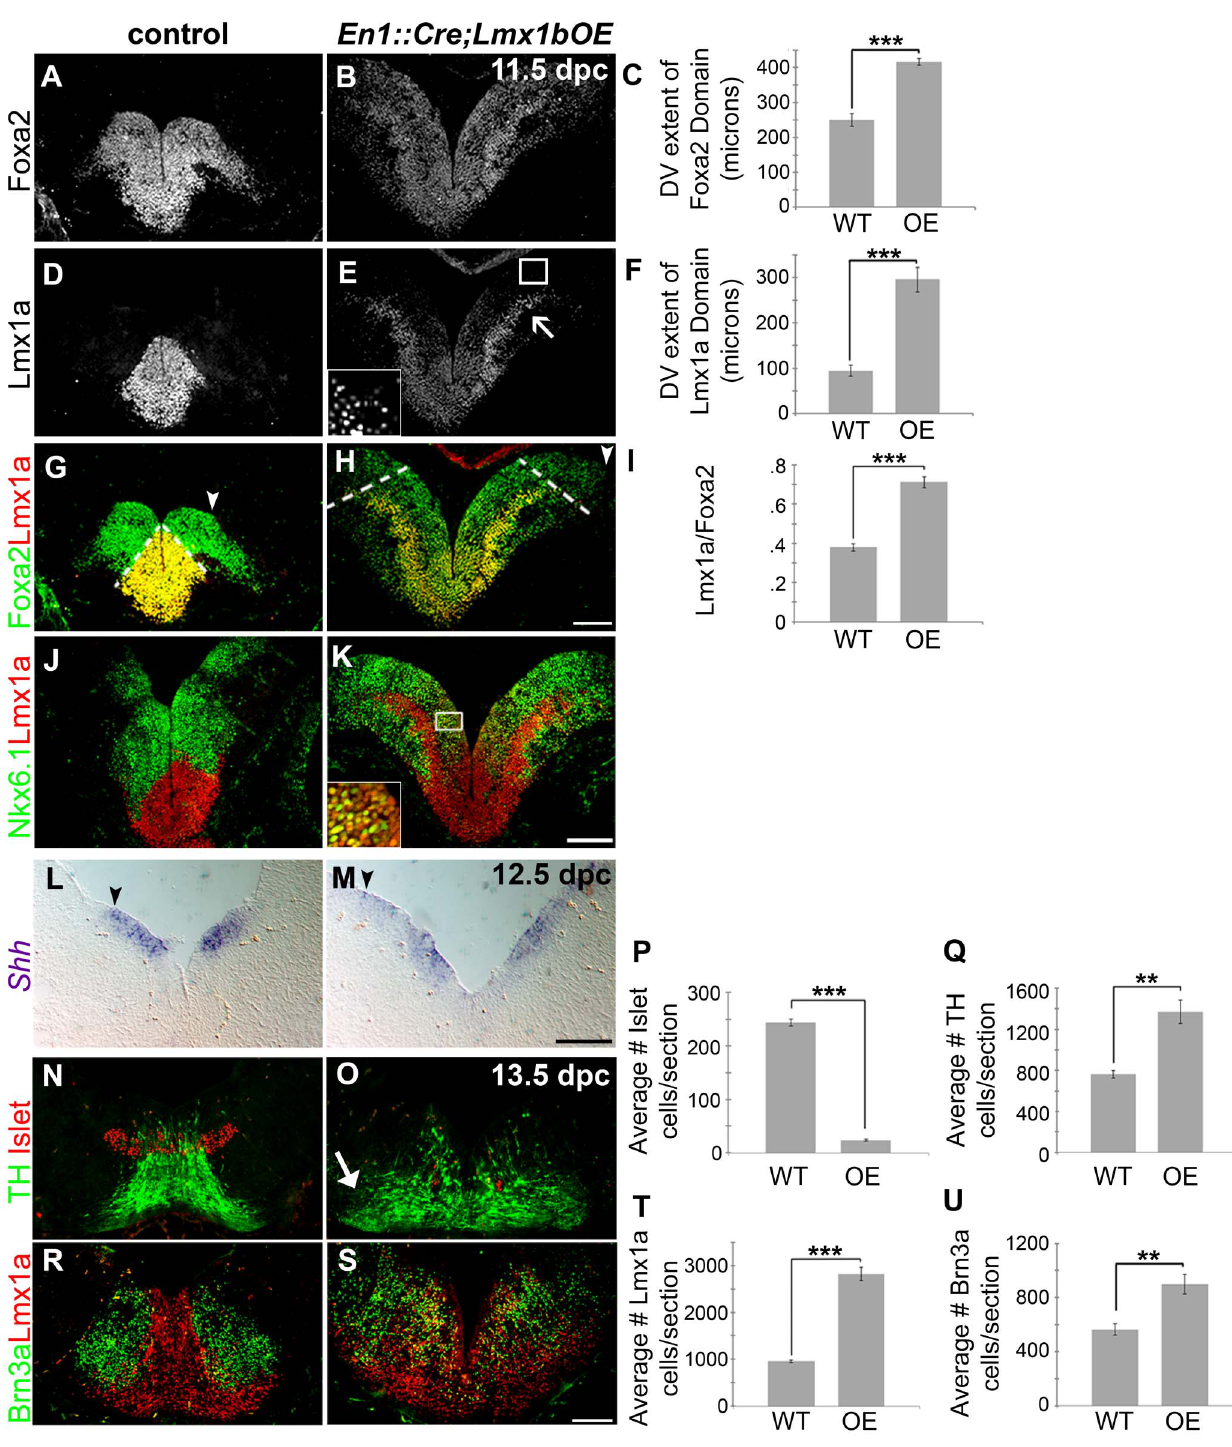
Figure 5. Maintenance of Lmx1b alters the size of the FP, the mDA progenitor pool, and ventral midbrain patterning. (A–K) Immunolabeling of 11.5 dpc En1::Cre;Lmx1bOE embryos revealed the dorsal expansion of Foxa2 and Lmx1a progenitor domains, although per cell levels of both markers were reduced. The closed white arrowheads indicate the dorsal border of Foxa2 expression, graphically represented in C (n=3; control mean=251.27 6 18.20 m M, mutant mean=416.19 6 9.20 m M; p-value=0.855E-05). The dotted white lines indicate the dorsal border of Lmx1a expression, graphically represented in F (n=3; control mean=94.67 6 11.73 m M, mutant mean=295.30 6 26.58 m M; p-value=0.0002), and as a normalized ratio in I (p-value=0.0006) (white box in E surrounds the border region of Lmx1a progenitors, which is shown at a higher magnification and exposure in the inset). Ectopic Lmx1a + neurons appear to emanate from the lateral Foxa2 regions (open arrow). In these lateral regions, a mixed Lmx1a + /Nkx6.1 + progenitor pool was observed (white box in K surrounds region shown in inset). (L–M) At 12.5 dpc Shh expression was also expanded dorsally (closed black arrowheads indicate the dorsal border of expression). (N–U) In 13.5 dpc En1::Cre;Lmx1bOE embryos we found a 90% reduction in Islet + oculomotor neurons (n=3; control mean=243.57 6 6.33, mutant mean=23.58 6 2.01; p-value=1.66E-05), an 80% increase in